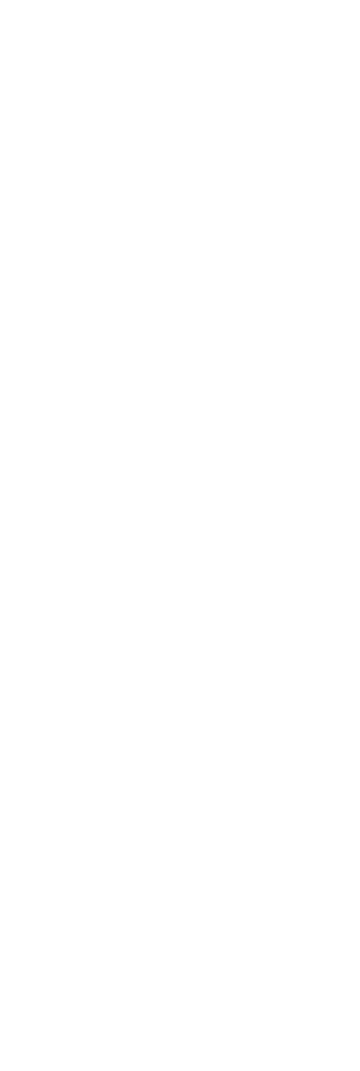
FIGURE 1 | Number of individuals tested in the Jeffrey ’ s Insights program based on geographic region. (A) Number of individuals tested globally by country in the program. The numbers indicate the number of individuals tested from each country. Countries are colored from light to dark to correspond to the relative number of individuals tested from low to high, respectively. (B) Number of individuals tested in the U.S. by state. The numbers indicate the number of individuals tested from each state. The color scale represents the relative number of individuals tested in each state with the light blue corresponding to a few individuals tested to dark blue indicating the states with the highest numbers of individuals